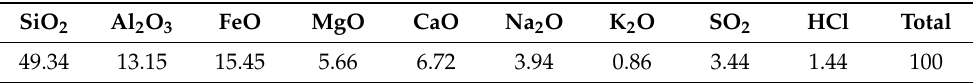
Table 1. Chemical composition of the rock used in the modeling, as created based on the composition of Darwin-type conglomerates in Gale crater [25].